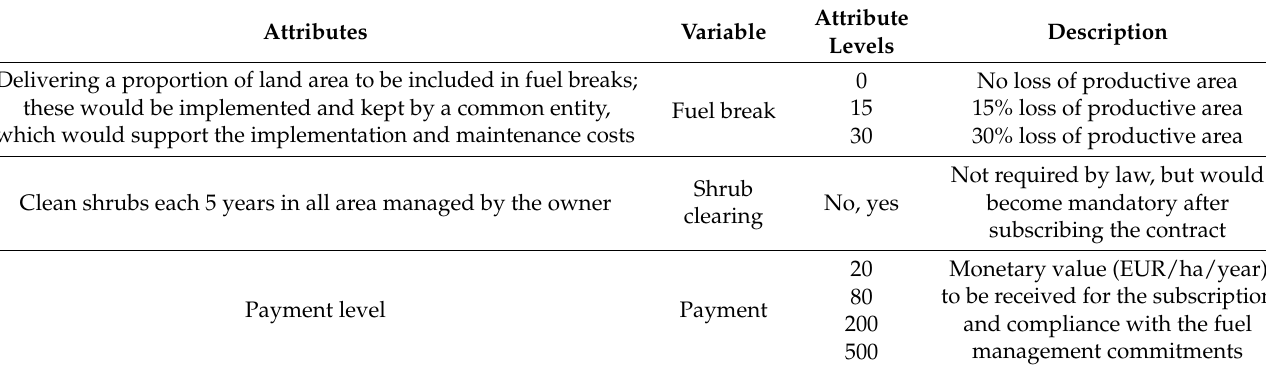
Table 1. Attributes and attribute levels used in the choice experiment.